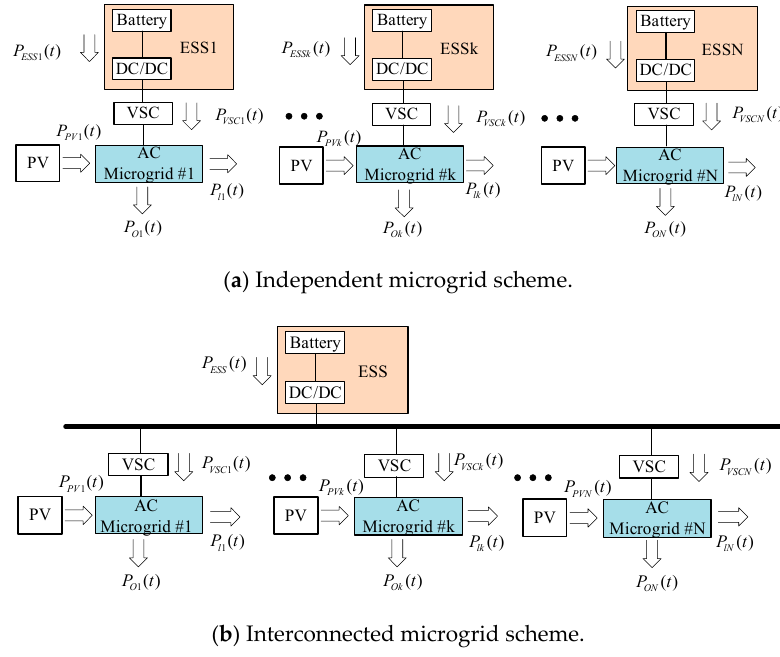
( b ) Interconnected microgrid scheme. Figure 2. Active power flow for power fluctuation analysis. Figure 2. Active power flow for power fluctuation